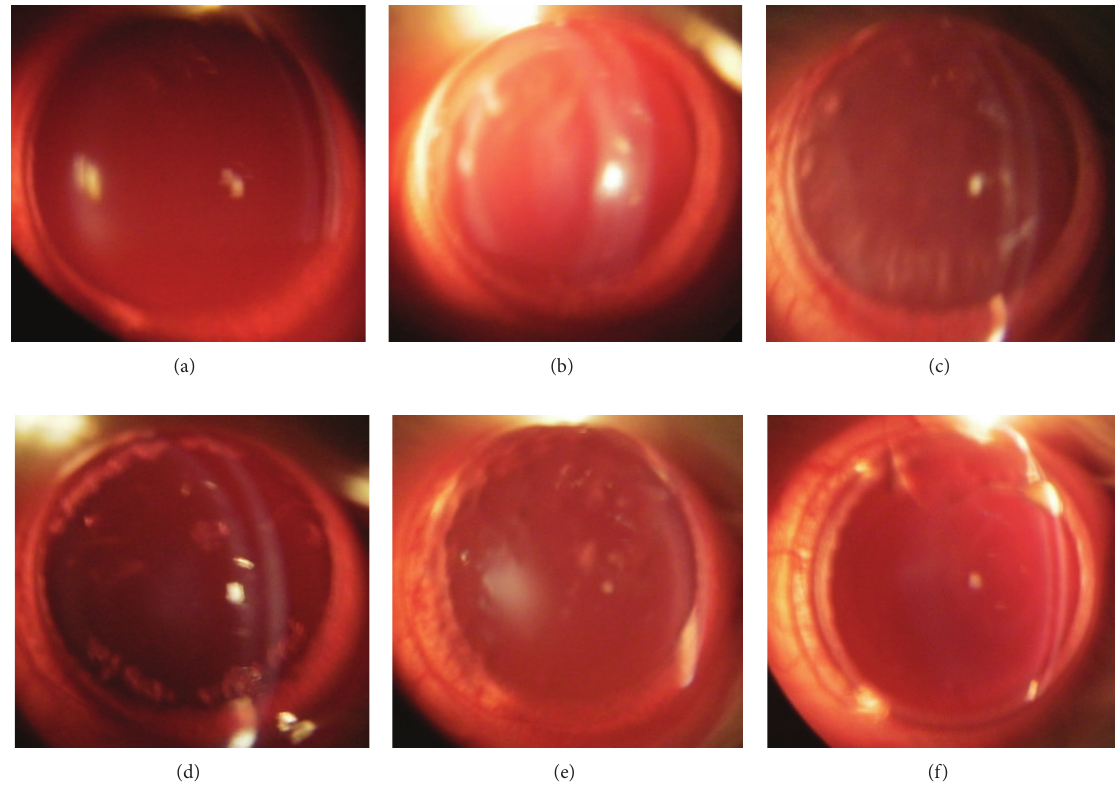
Figure 1: Two weeks after diabetic modeling by STZ injection, the onset of diabetic cataracts in rats before rHV3 eye drops administration. (a): normal control (group A); (b): diabetic cataracts to be untreated (group B); (c): diabetic cataracts to be treated with 50 𝜇 L (one drop) of 0.053 𝜇 g/ 𝜇 L pirenoxine sodium eye drops each time (group F); (d), (e), and (f): diabetic cataracts to be treated with 50 𝜇 L (one drop) of 0.5, 1, 2ATU/ 𝜇 L rHV3 eye drops each time, respectively (groups C, D,